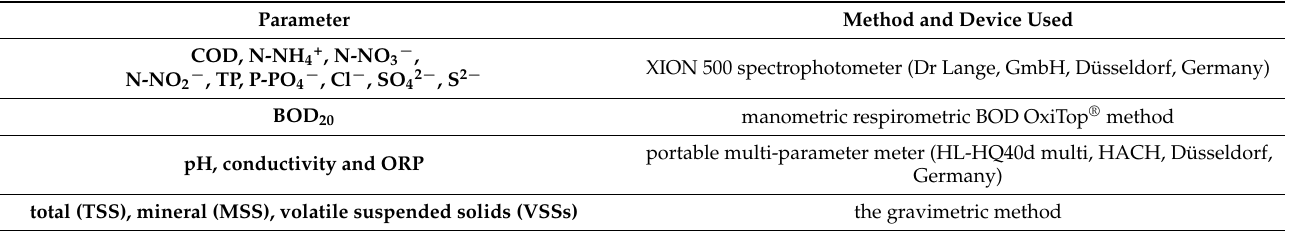
Table 1. List of the physico-chemical analysis